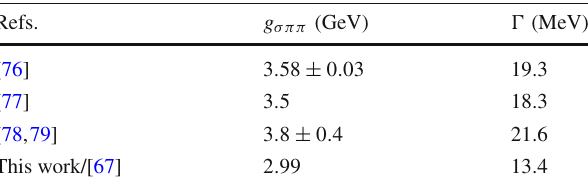
Table 1 Estimation of the uncertainties in (cid:8) from the coupling g σ,ππ with some g σ,ππ taken from Ref. [61]